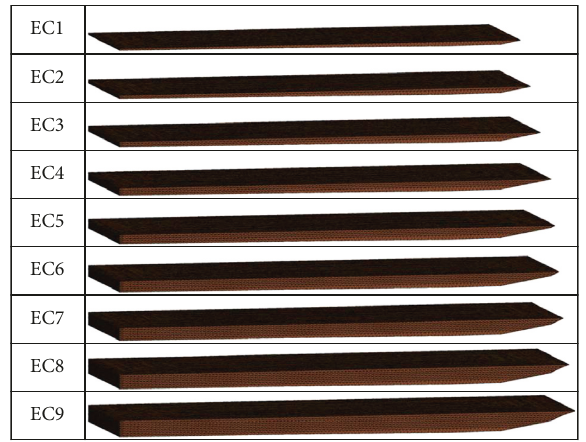
Figure 17: Embankment construction term.